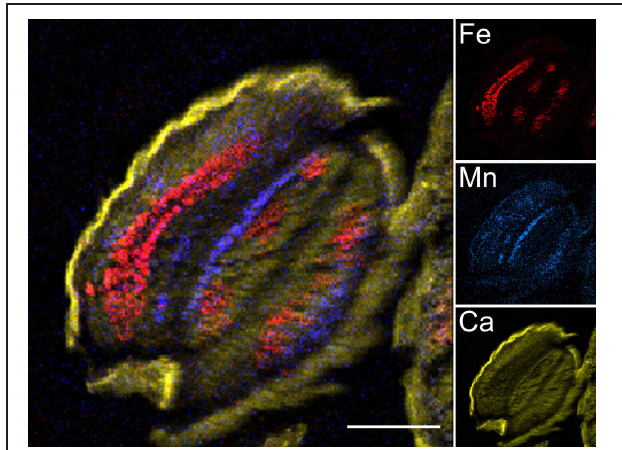
FIGURE 2 | µ PIXE elemental reconstituted image of Arabidopsis thaliana dry seed section. Total X-ray spectra of areas scanned with 3 MeV proton beam were collected. Specific distributions of Fe, Mn, and Ca in a 30 µ m thick longitudinal section of Arabidopsis dry seed are shown overlaid (large image) and separately (small images). False color images and reconstitution were obtained using ImageJ free software. Scale bar: 100 µ m; red, Fe; blue, Mn; yellow, Ca. FIGURE 3 | Regions of interest for µ PIXE elemental quantification.